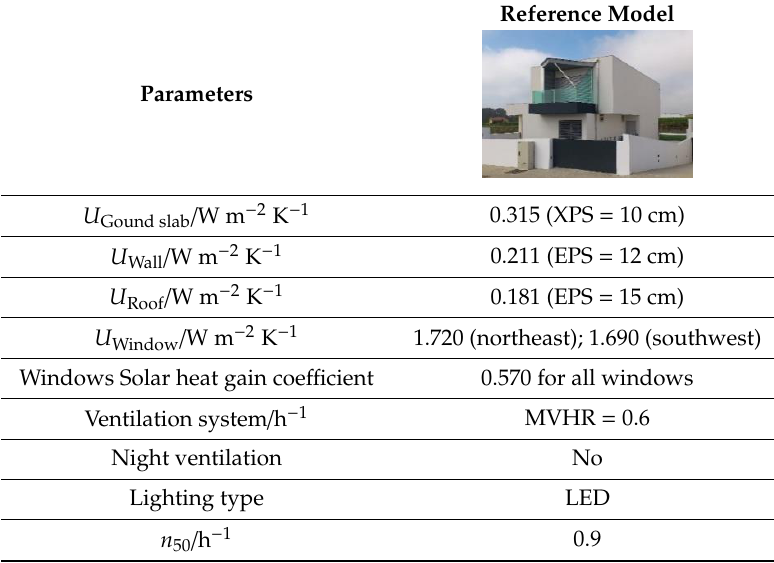
Table 1. Case study: general characterization.